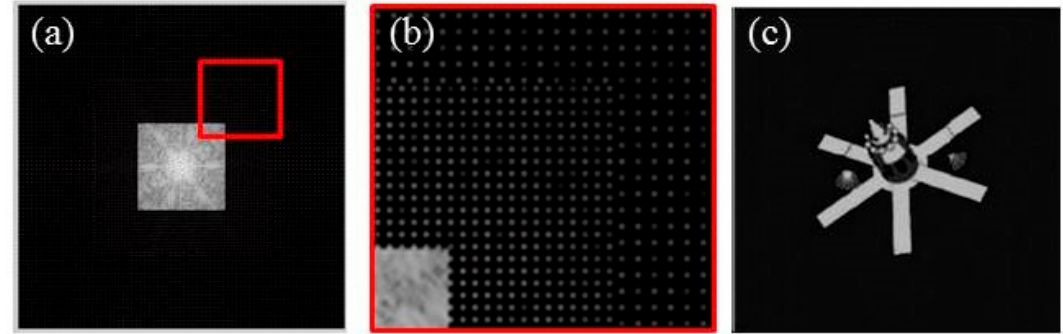
Figure 9. ( a ) Mutual intensity spectrum detected with the complex rectangular sub-aperture arrangement method ( △ u1 = 0.66, △ u2 = 0.99, N = 200); ( b ) partial enlargement of the spectrum; ( c ) actual imaging of the system.